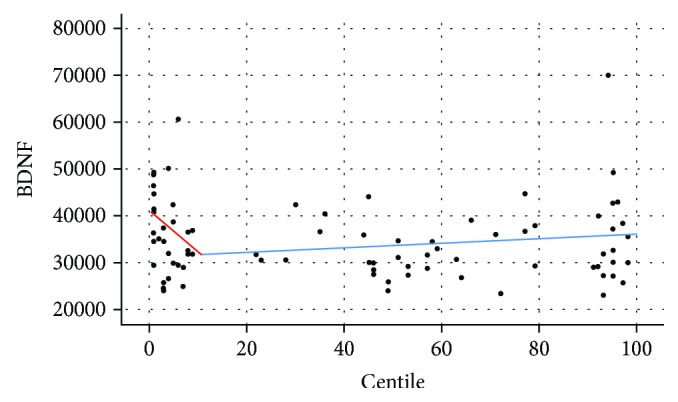
Regression analysis line graph of variables, BDNF (pg/ml) and fetal growth centile: a bimodal depiction of BDNF amniotic fluid levels is shown.